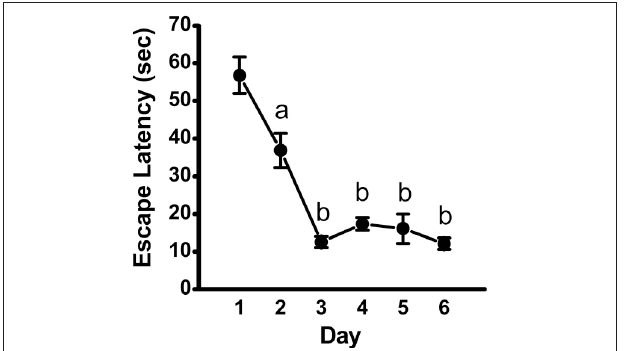
FIGURE 1 | Escape latency across training days in the acquisition phase of the MWM. Plot depicting time to locate the hidden platform (mean ± SEM; n = 10 ) across training days, as assessed using repeated-measures ANOVA, followed by Fisher’s LSD post-hoc comparisons. a, significantly different from Day 1, p < 0.01 ; b, significantly different from Day 1 and Day 2, p < 0.001 .